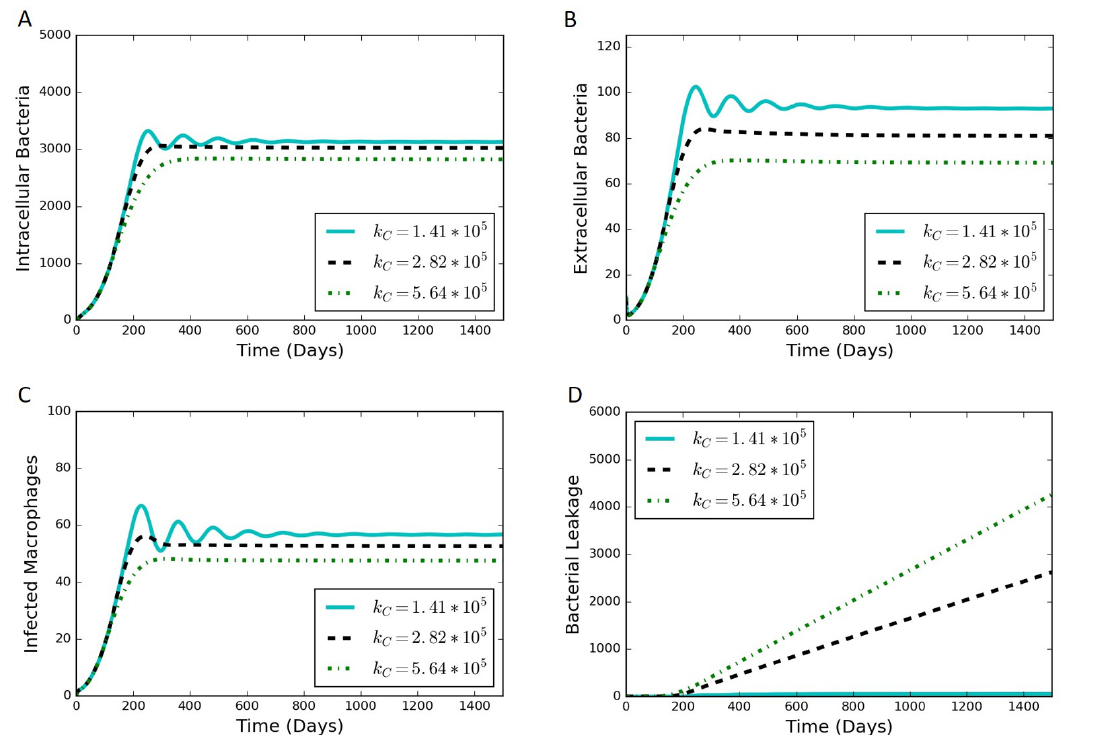
Figure 6. Simulation results from varying values of k C , where increasing k C leads towards a leaking state of the granuloma. ( A ) intracellular bacteria count vs. time; ( B ) extracellular bacteria count vs. time; ( C ) infected macrophage count vs. time; ( D ) cumulative bacterial leakage vs.